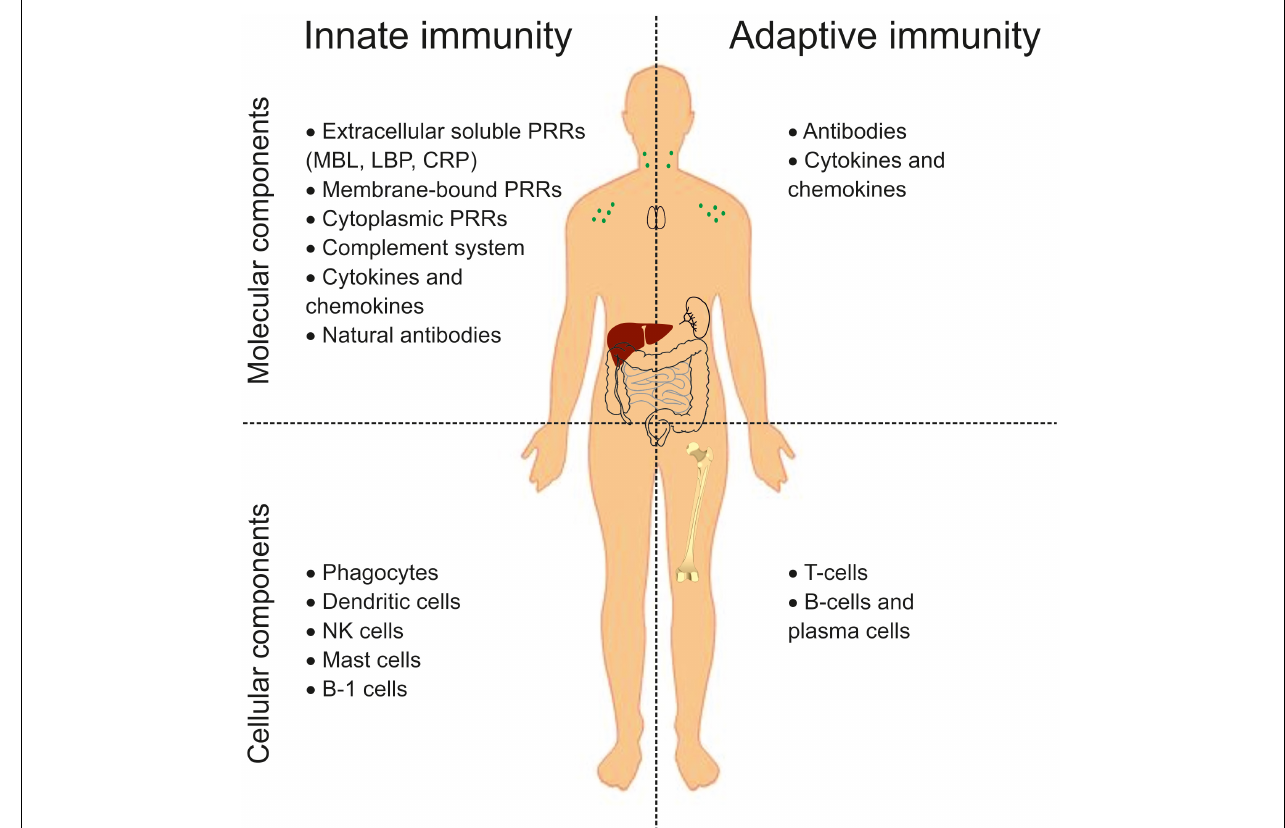
FIGURE 1 | An overview of the innate and adaptive immune system components. PRRs, pattern recognition receptors; MBL, mannose binding lectin; LBP, lipopolysaccharide binding protein; CRP, C-reactive protein, NK, natural